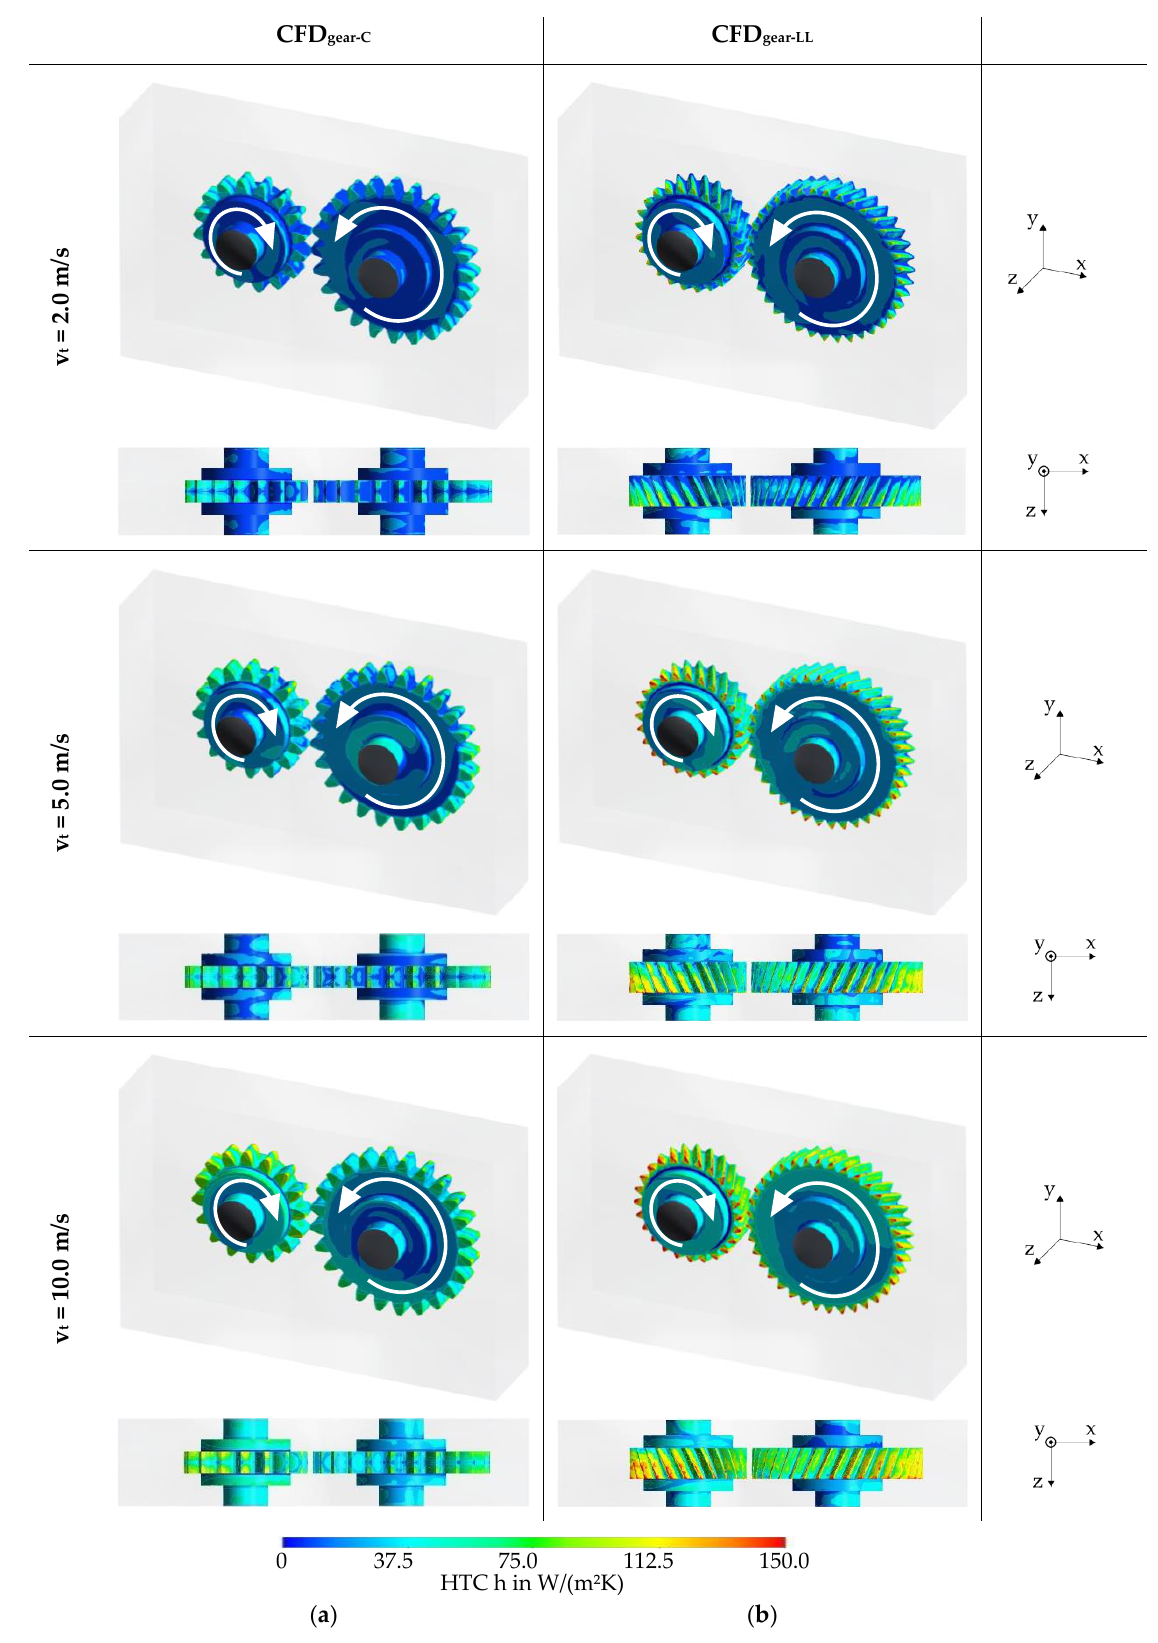
Figure 7. Heat transfer coefficient h between the gear surfaces and air for v t = {2.0; 5.0; 10.0} m/s in 3D and top view for gear-C ( a ) and for gear-LL ( b ).